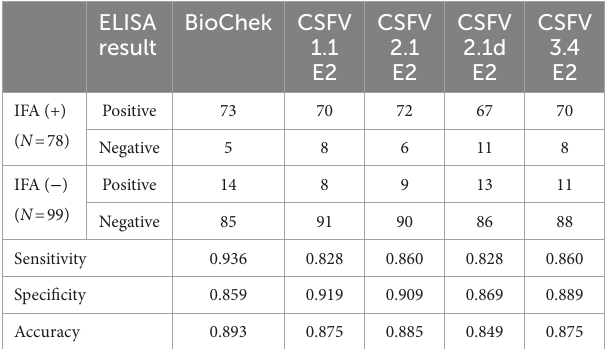
TABLE 1 Summarized results of in-house E2 glycoproteins-based ELISAs and the commercial ELISA in detection of IFA-confirmed positive (+)